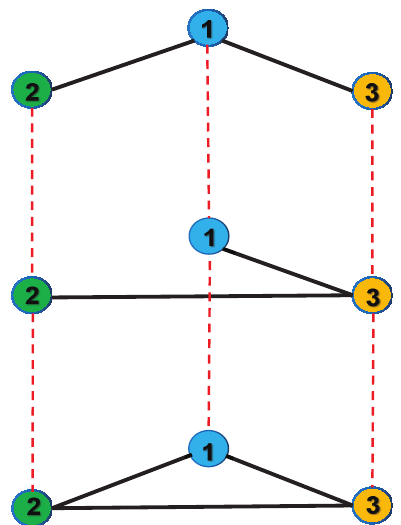
Figure 1. Topology of the multiplex network (1).